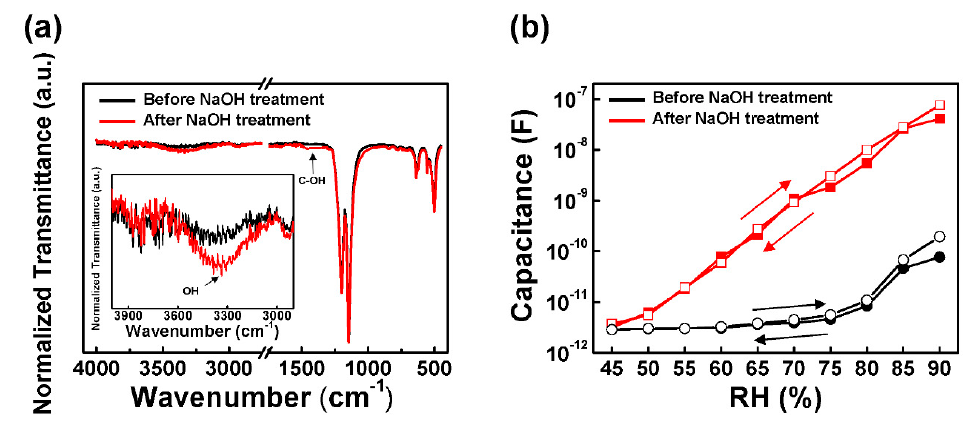
Figure 2. ( a ) FT-IR spectra of H-PTFE membrane with respect to NaOH treatment. Inset: 2900–4000 cm − 1 region; ( b ) sensing response and hysteresis of H-PTFE flexible humidity sensor before and after NaOH